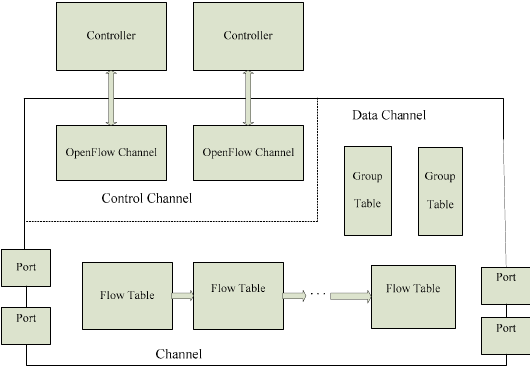
Figure 3. Key components of OpenFlow switches.